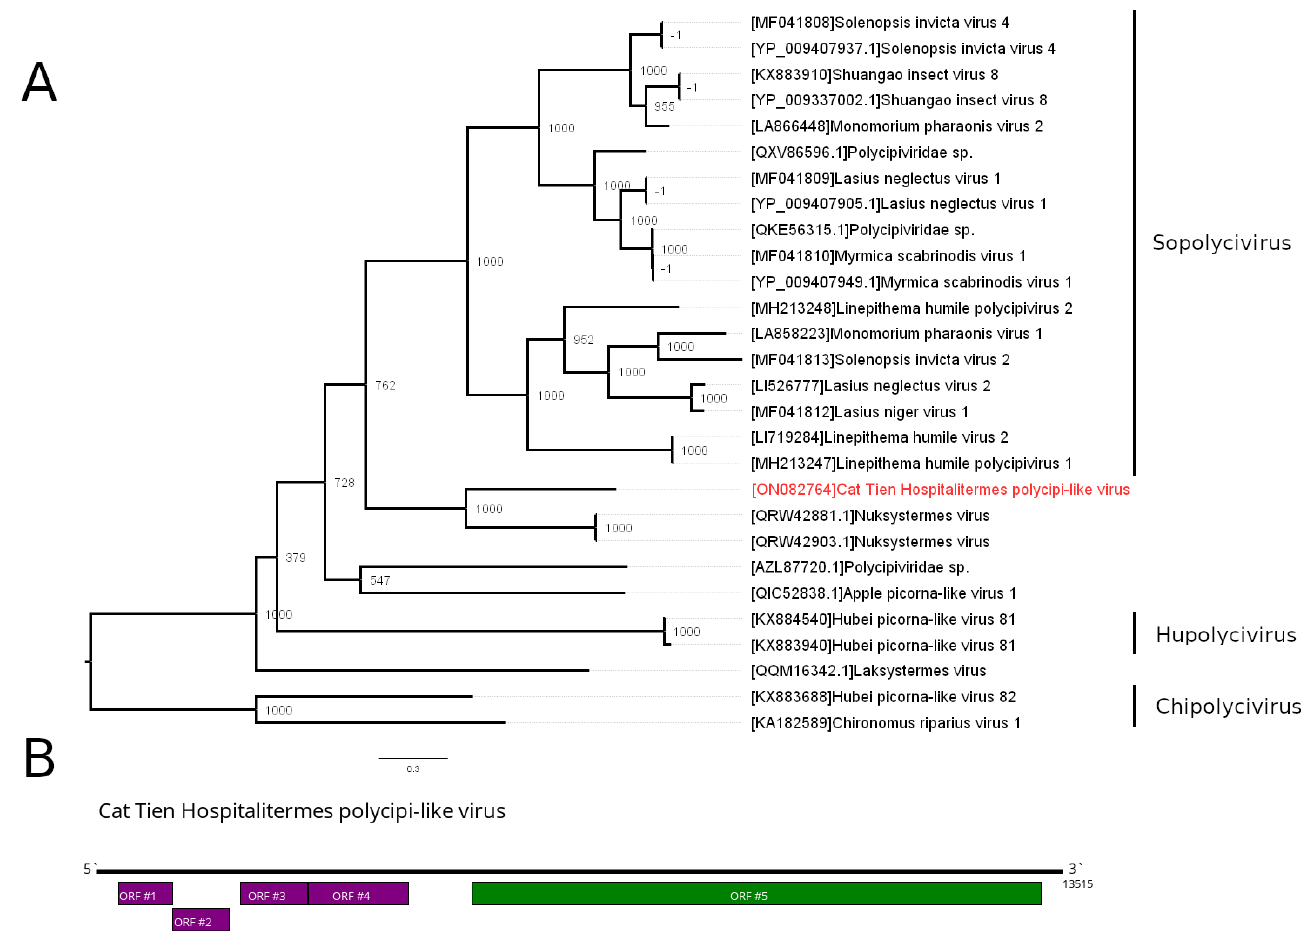
Figure 3. Phylogenetic relationships and genetic structure of the Cat Tien Hospitalitermes polycipi-like virus (СHPLV). ( A ) Phylogenetic relationships of the СHPLV. Analysis was performed using amino acid sequences of viral RdRp-encoding polyprotein, with 1000 bootstrap replicates. Bootstrap support values are shown for each node. Scale bar represents the number of amino acid substitutions per site. СHPLV is marked red. Genera of the Polycipividae family are marked on the right. ( B ) Scheme of the СHPLV genome, with RdRp-encoding polyprotein marked in green.